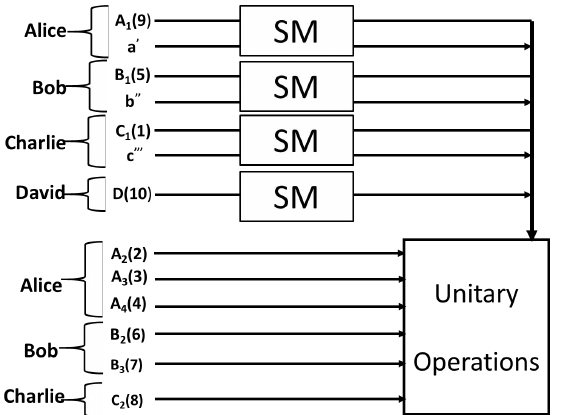
Figure 3. Diagram of four-party controlled cyclic asymmetrical RSP protocol, where SM is short for single-qubit